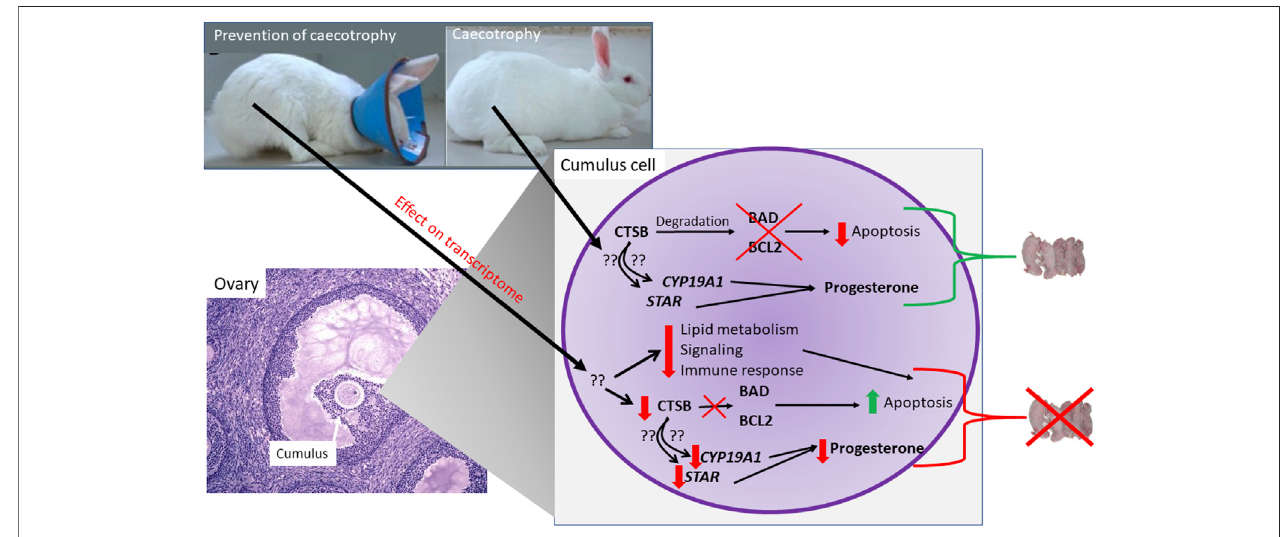
FIGURE 8 | Model summarizing fi ndings from the